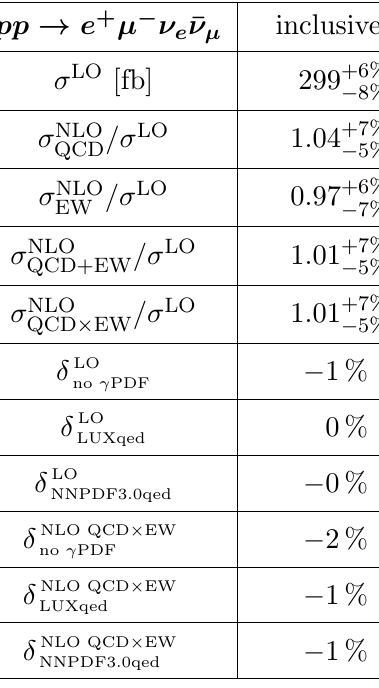
Table 5 . Cross-sections for pp e + (cid:22) (cid:0) (cid:23) e (cid:22) (cid:23) (cid:22) at 13 TeV with CT14qed PDFs and (cid:12)ducial cuts ! of table 2 (1 st column) plus one additional cut on p T ;‘ (2 nd column), E T (3 rd column), or m ‘‘ 1 6 (4 th column). The top row lists LO cross sections, while the following four rows give the relative change induced by the NLO QCD, EW, QCD+EW and QCD EW corrections. The sub- and (cid:2) superscripts give their respective relative uncertainties determined through customary (cid:22) R and (cid:22) F variations, while keeping the reference LO cross section (cid:12)xed in the ratios. The impact of alternative descriptions of the photon density are explored by neglecting it entirely (no (cid:13) PDF) or using the densities provided by the LUXqed and NNPDF3.0qed sets. For quarks and gluons always the central PDF set CT14qed is